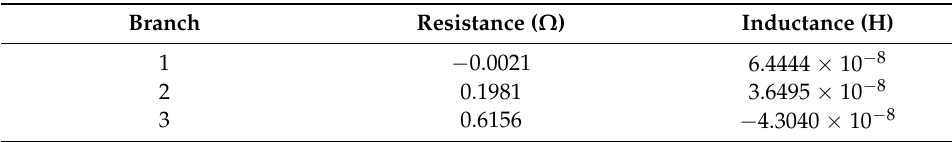
Figure 3. Per unit cable resistance of the measurement and simulation. Table 1. Parameters of three branches.